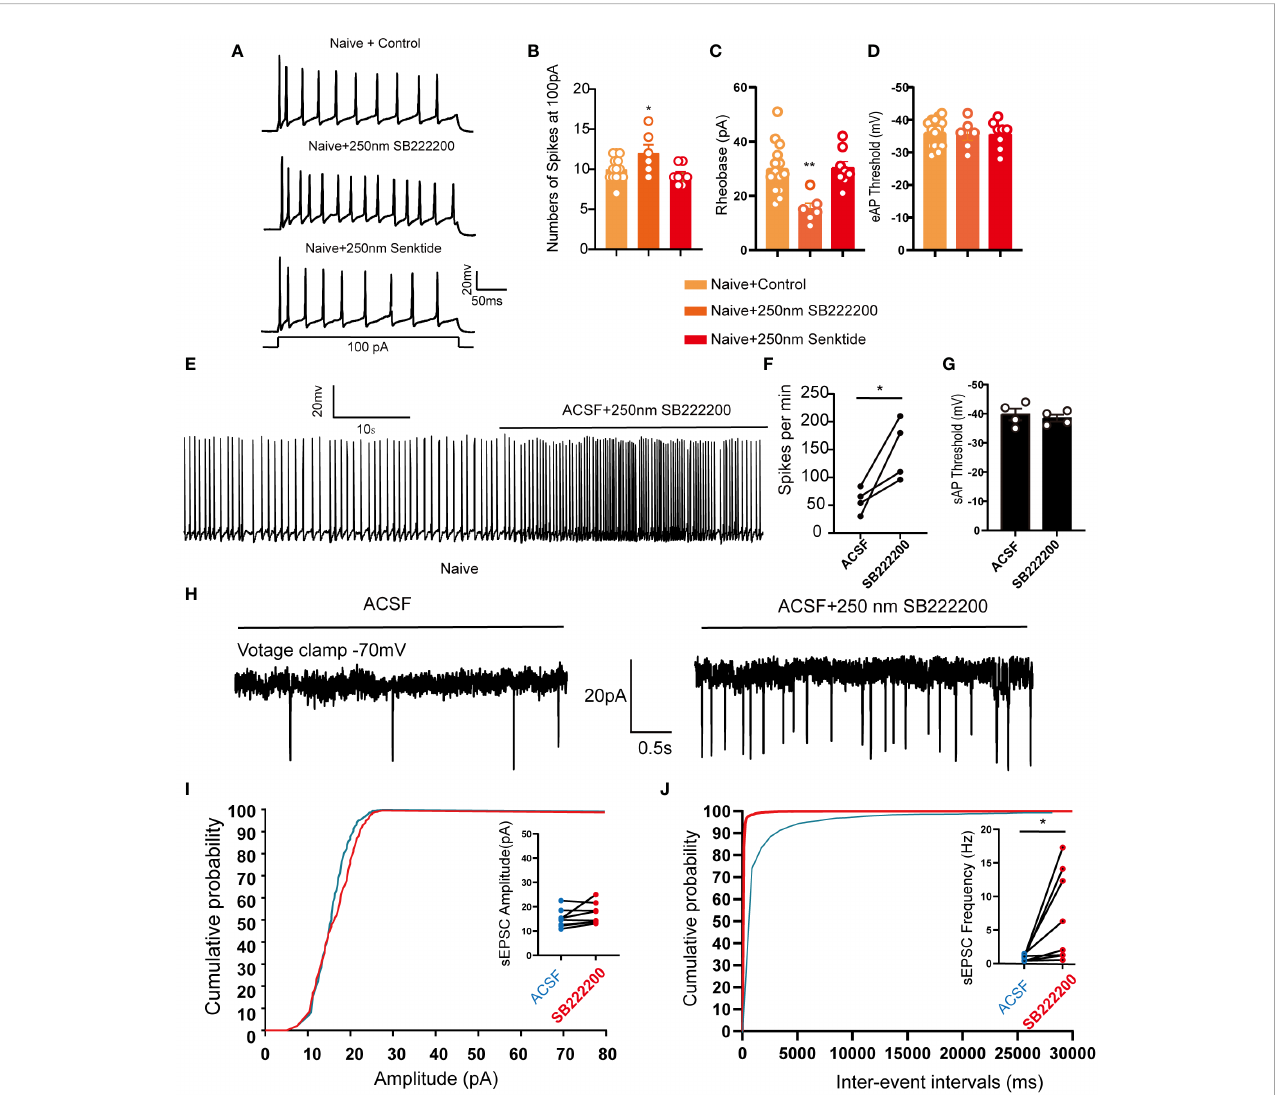
FIGURE 6 LHb neurons were activated after pharmacological inhibition of NK3R in naive mice. (A) Patch-clamp recording showing the typical traces recorded from LHb neurons with SB222200 and senktide perfusion in naive mice. (B) Data of evoked action potential fi ring spikes at 100 pA current stimulation recorded from LHb neurons with SB222200 and senktide perfusion in naive mice (*p < 0.05 vs. the Naive+control group, n = 12 neurons in the control group from 6 mice, n = 6 neurons from 6 mice in the SB222200 group, n = 7 neurons from 7 mice in the senktide group). (C, D) Data of rheobase (C) and evoked action potential thresholds (D) recorded from LHb neurons with SB222200 and senktide perfusion in naive mice (**p < 0.01 vs. the Naive +control group, n = 14 neurons in the control group from 6 mice, n = 6 neurons from 6 mice in the SB222200 group, n = 8 neurons from 7 mice in the senktide group). (E) Typical traces of spontaneous action potential fi ring spikes recorded from LHb neurons with SB222200 perfusion in naive mice. (F, G) Data of spontaneous action potential fi ring spikes (F) and spontaneous action potential thresholds (G) recorded from LHb neurons with SB222200 perfusion in naive mice (*p < 0.05 vs. arti fi cial cerebrospinal fl uid, n = 4 neurons from 4 mice). (H) Typical frequency and amplitude of sEPSCs of LHb neurons with SB222200 perfusion in naive mice. (I, J) Corresponding cumulative distributions and quanti fi cation of sEPSC amplitudes (I) and frequency (J) of LHb neurons with SB222200 perfusion in naive mice (*p < 0.05 vs. arti fi cial cerebrospinal fl uid, n = 8 neurons from 4